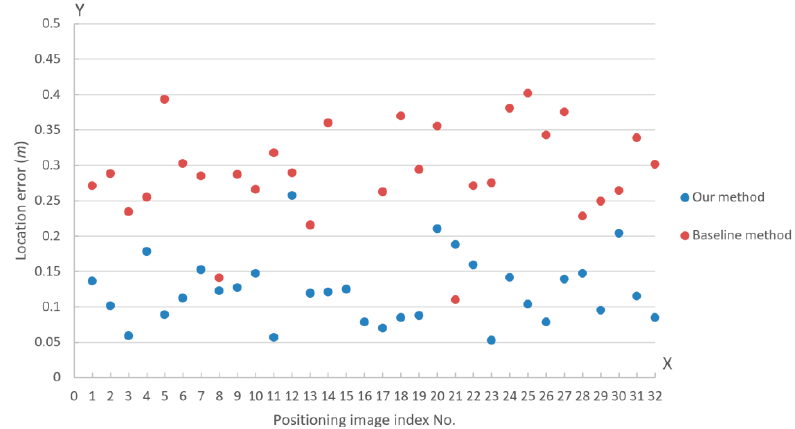
Figure 18. Scatter plot of the MSEP distribution.